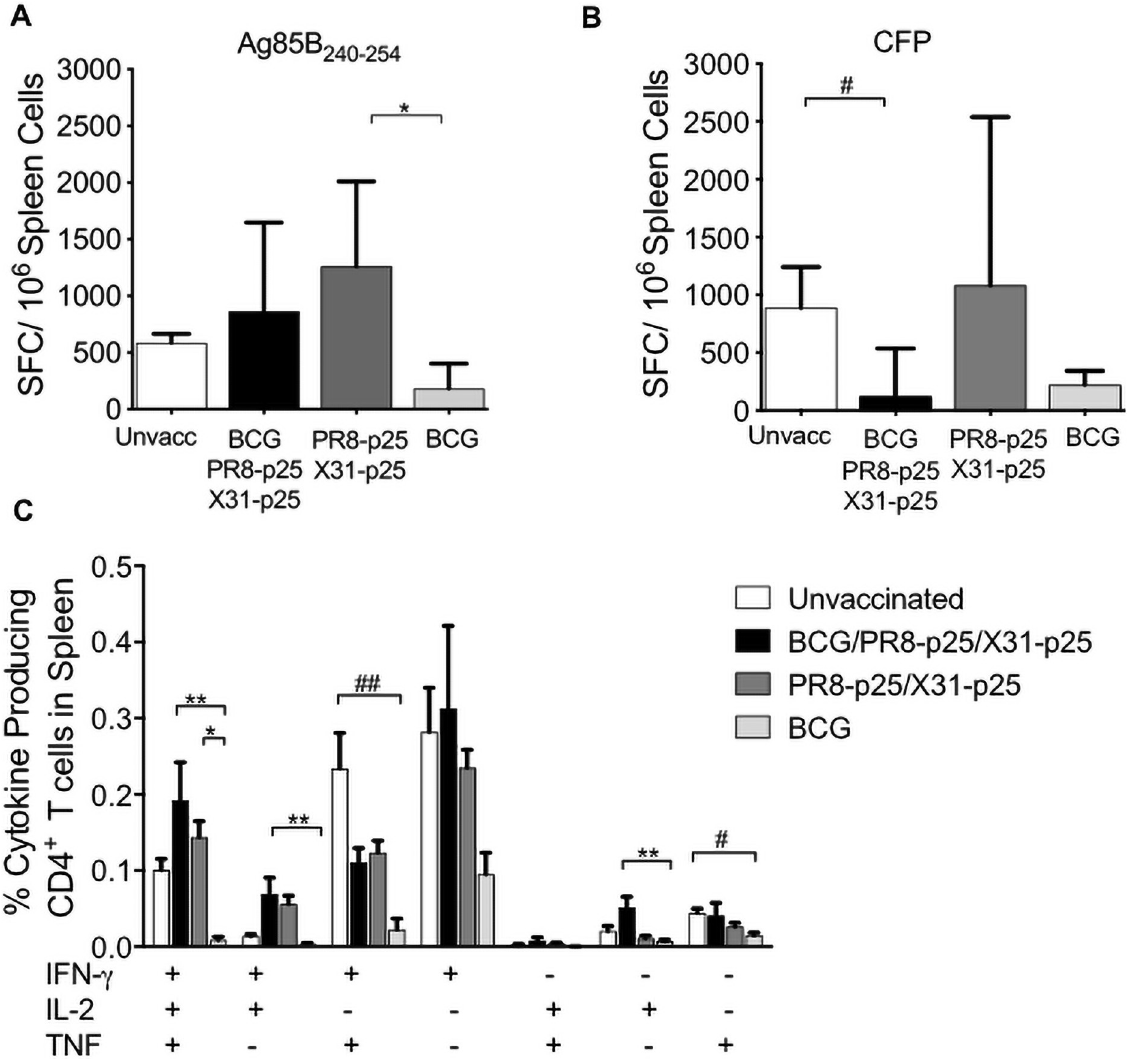
Fig 5. Cytokine production in the spleen at 4 weeks after aerosol challenge with M . tuberculosis . Mice were vaccinated with BCG and sequential PR8-p25 and X31-p25 rIAVs and challenged with M . tuberculosis as in Fig 3A. Four weeks after challenge, cytokine production by antigen-specific splenic CD4 + T cells was analyzed. (A) The frequency of T cells producing IFN- γ in response to 16-hour stimulation with p25 peptide, or (B) CFP, derived from M . tuberculosis , was analyzed by ELISpot. (C) The frequency of p25-specific CD4 + T cells producing IFN- γ , IL-2, and TNF following stimulation with p25 was analyzed by flow cytometry. Data are shown as the median and interquartile range (A, B) or the means ± SEM (C) and are representative of two independent experiments. Statistically significant differences were determined by one-way ANOVA ( � ) or Kruskal-Wallis ( # ) ( � p < 0.05; �� p < 0.01; ��� p <